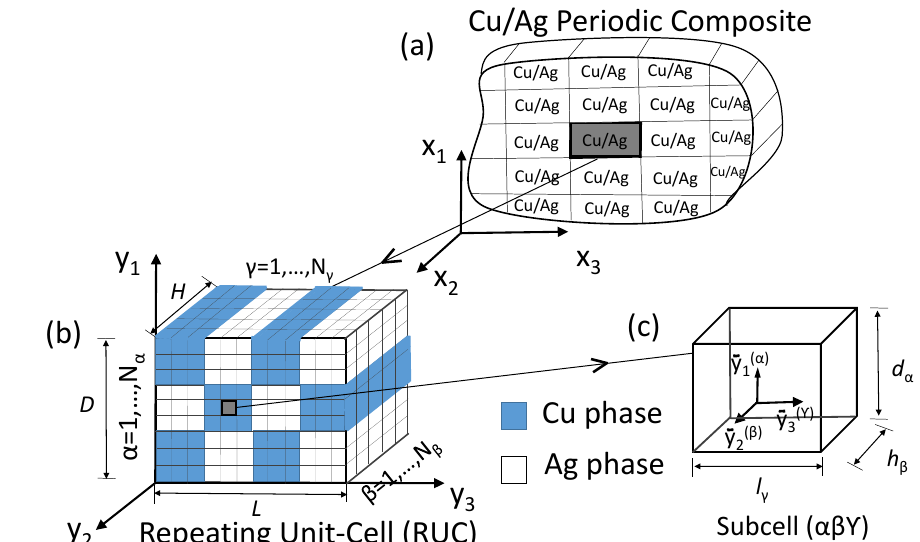
Figure 1. Schematic illustration of a two-phase composite. ( a ) Cu-Ag composite containing multiple repeating unit-cells (RUCs), defined with respect to global coordinates ( x 1 , x 2 , x 3 ); ( b ) the repeating unit-cell (RUC), defined in the local coordinates ( y 1 , y 2 , y 3 ); it is separated into N α , N β , N γ subcells, in the y 1 , y 2 and y 3 directions, respectively; and ( c ) a characteristic subcell ( αβγ ), defined within a local coordinate system ( y α , y β , y γ ) whose origin is located at the 1 2 3